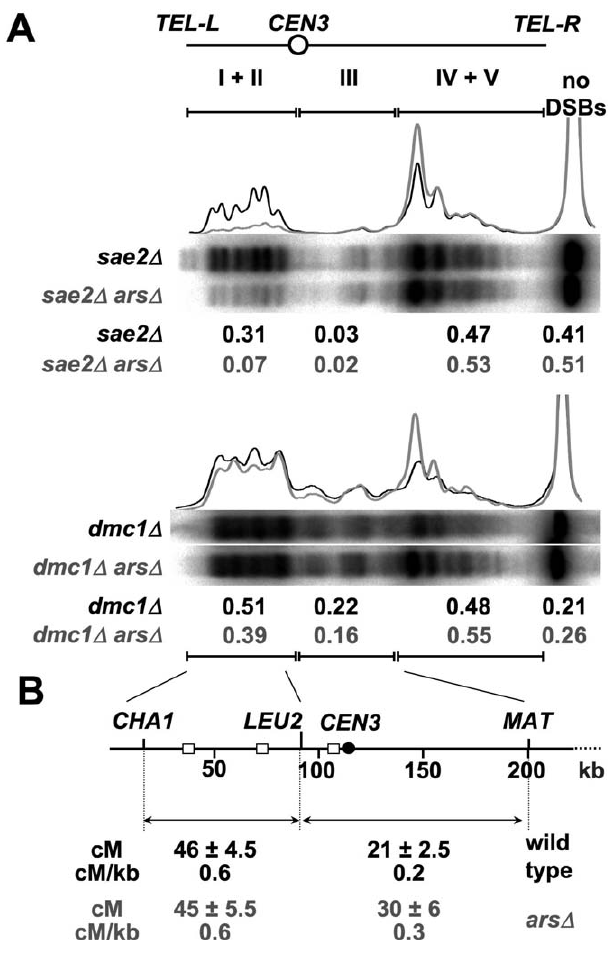
Figure 1. Delaying Replication Does Not Affect Crossing-Over in Wild Type or DSB Frequencies in dmc1 D (A) Southern blots of pulsed-field gels, probed with a left end–adjacent probe (nt 15,838–16,857) to detect DSBs on chromosome III in a normal